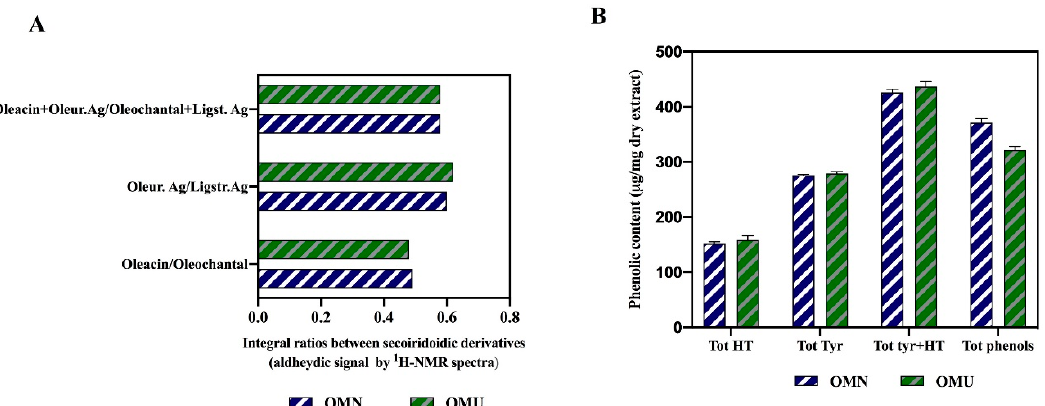
Figure 1. Analysis of secoiridoids. ( A ) Ratios of the integrals corresponding to the signals of secoiridoidic monoaldehydes in 1 H-NMR spectra of the dry extracts from OMN and OMU samples. Oleur. Ag, aglycone of oleuropein; Ligstr. Ag. aglycone of ligstroside. ( B ) Total tyrosol + hydroxytyrosol (after hydrolysis) and phenolic content (according to the IOC method) in the dry extracts from OMN and OMU oil; each data represents the mean of the analysis of three extracts of the same samples.